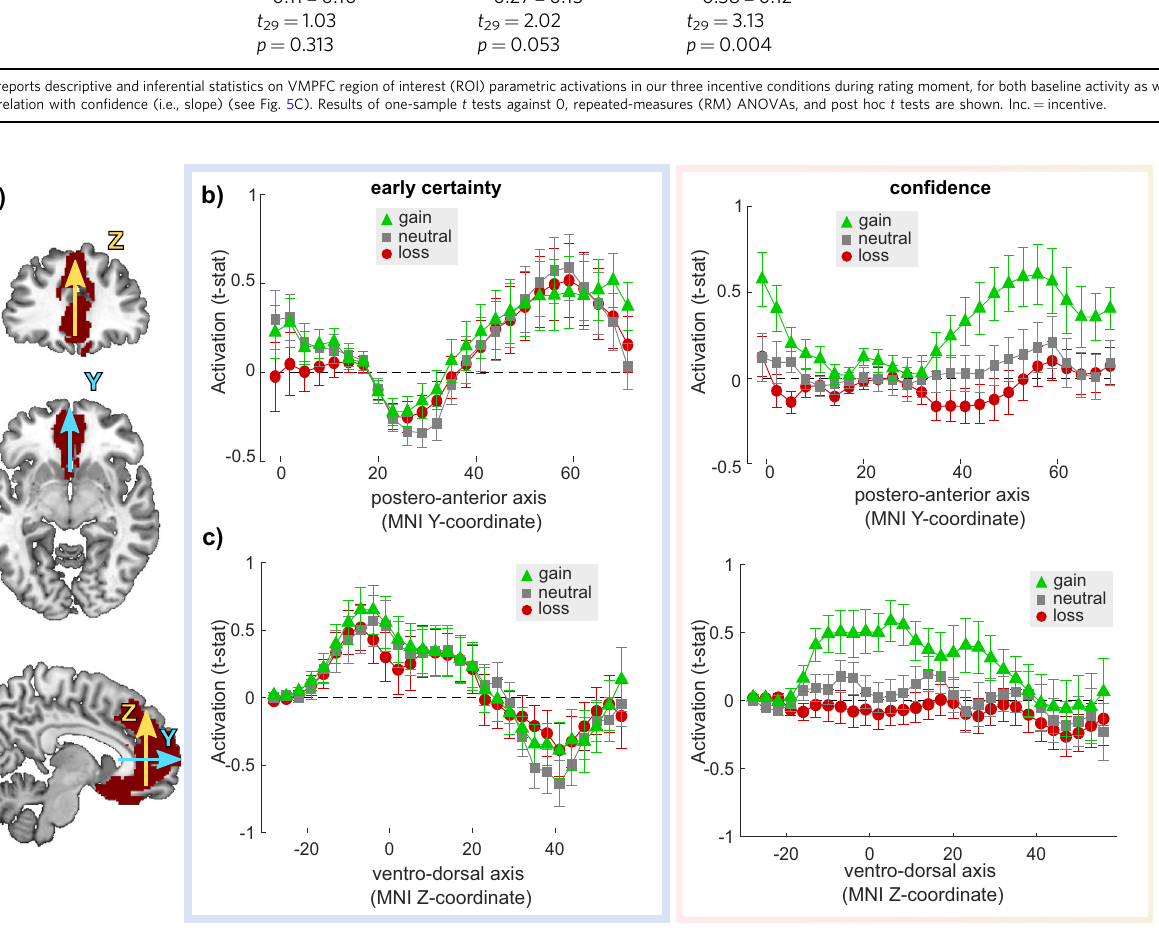
Fig. 6 Activation in ventromedial prefrontal cortex across Y and Z dimensions. a Large anatomical medial prefrontal cortex region of interest (ROI). The Y (blue) and Z (yellow) arrows indicate the dimensions over which the signal is extracted and marginalized — respectively, corresponding to the postero- anterior axis and ventro-dorsal axis. b – c MPFC region of interest (ROI) analysis of con fi dence activations, at the voxel-level, marginalized over the Y ( b ) and Z ( c ) dimensions. Voxel-wise T values corresponding to regression slope were extracted in the three incentive conditions (green: + 100; gray: 0; red: − 100), and at the two time points of interest (left: stimulus/choice; right: incentive/rating), averaged over two dimensions and plotted as a function of the third dimension. Dots and error bars indicate sample mean ± standard error of the mean ( N =